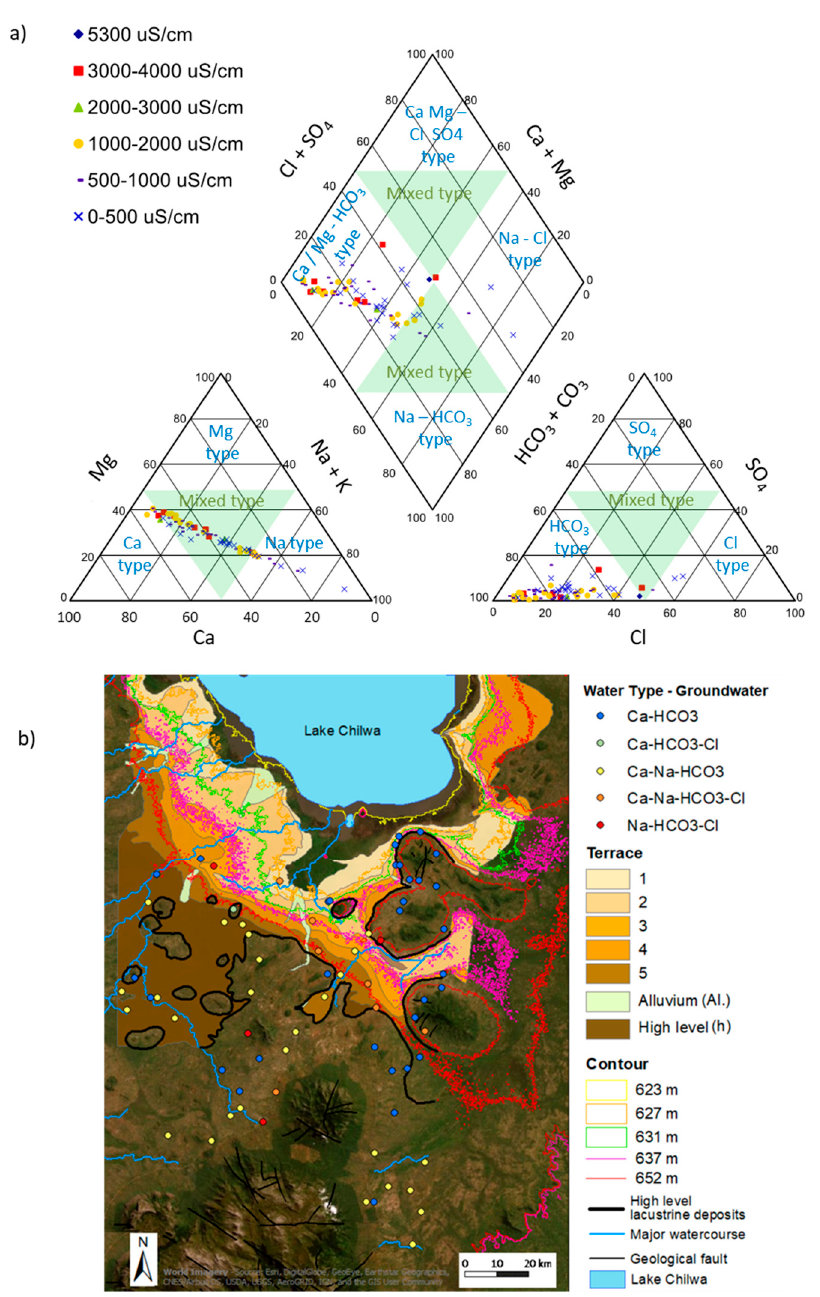
Figure 10. ( a ) Piper plot of observed Phalombe District groundwater data, and ( b ) spatial distribution of water types in groundwater. Conversion of EC to TDS may be made via: TDS = 0.602 EC + 59.78 (R 2 = 0.9814, n = 67) based on field EC and lab analysed sum of major ions.